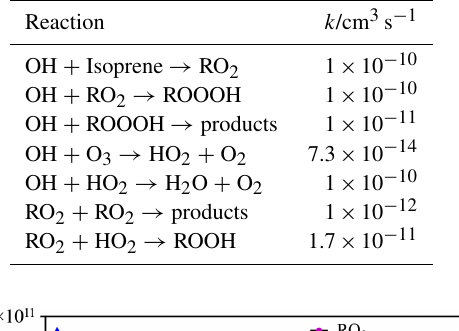
Figure 2. OH concentration time profiles following the photoly- sis of 600ppb O 3 (leading to initial OH concentrations of around 1.4 × 10 10 cm − 3 ) in the presence of 3 × 10 11 cm − 3 isoprene. For clarity, only every 10th photolysis shot is shown. Open black sym- bols show the FAGE signal before the first photolysis shot. Time resolution was decreased from 200µs to 4ms by averaging 20 data points for clarity only: full lines show a fit to a single exponential decay, carried out using non-averaged data between 0.02s and the end of the data set. The inset shows a vertical zoom; for clarity only the pre-photolysis signal as well as the signals for the first and last pulse with the corresponding fits are shown.